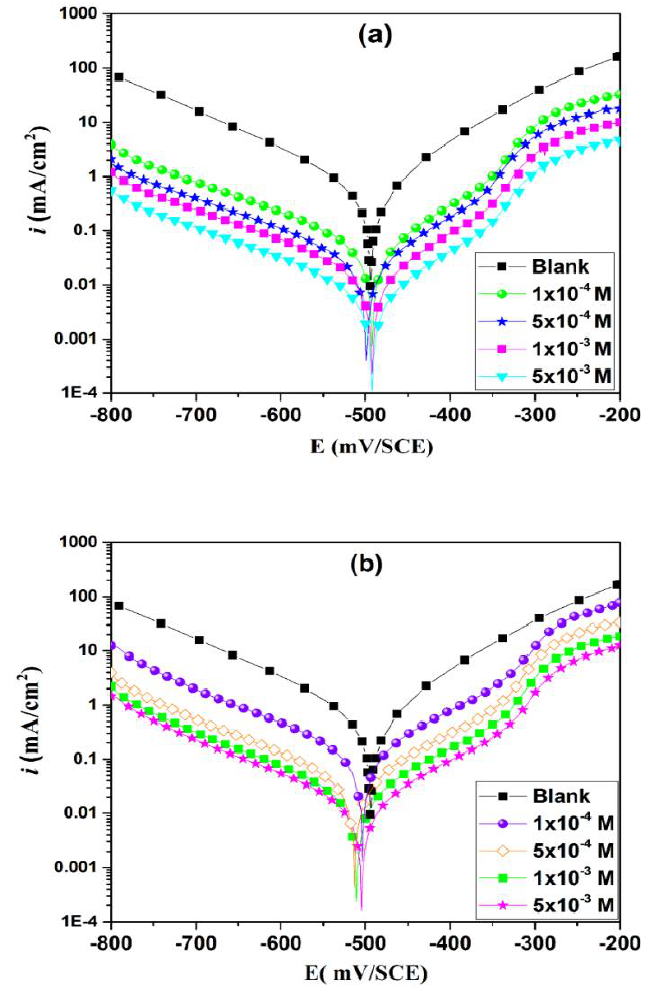
Figure 3. Potentiodynamic polarization curves of MS in 1.0 M HCl without and with different concentrations of 3-BIT ( a ) and 2-BIT ( b ) at 303 K.